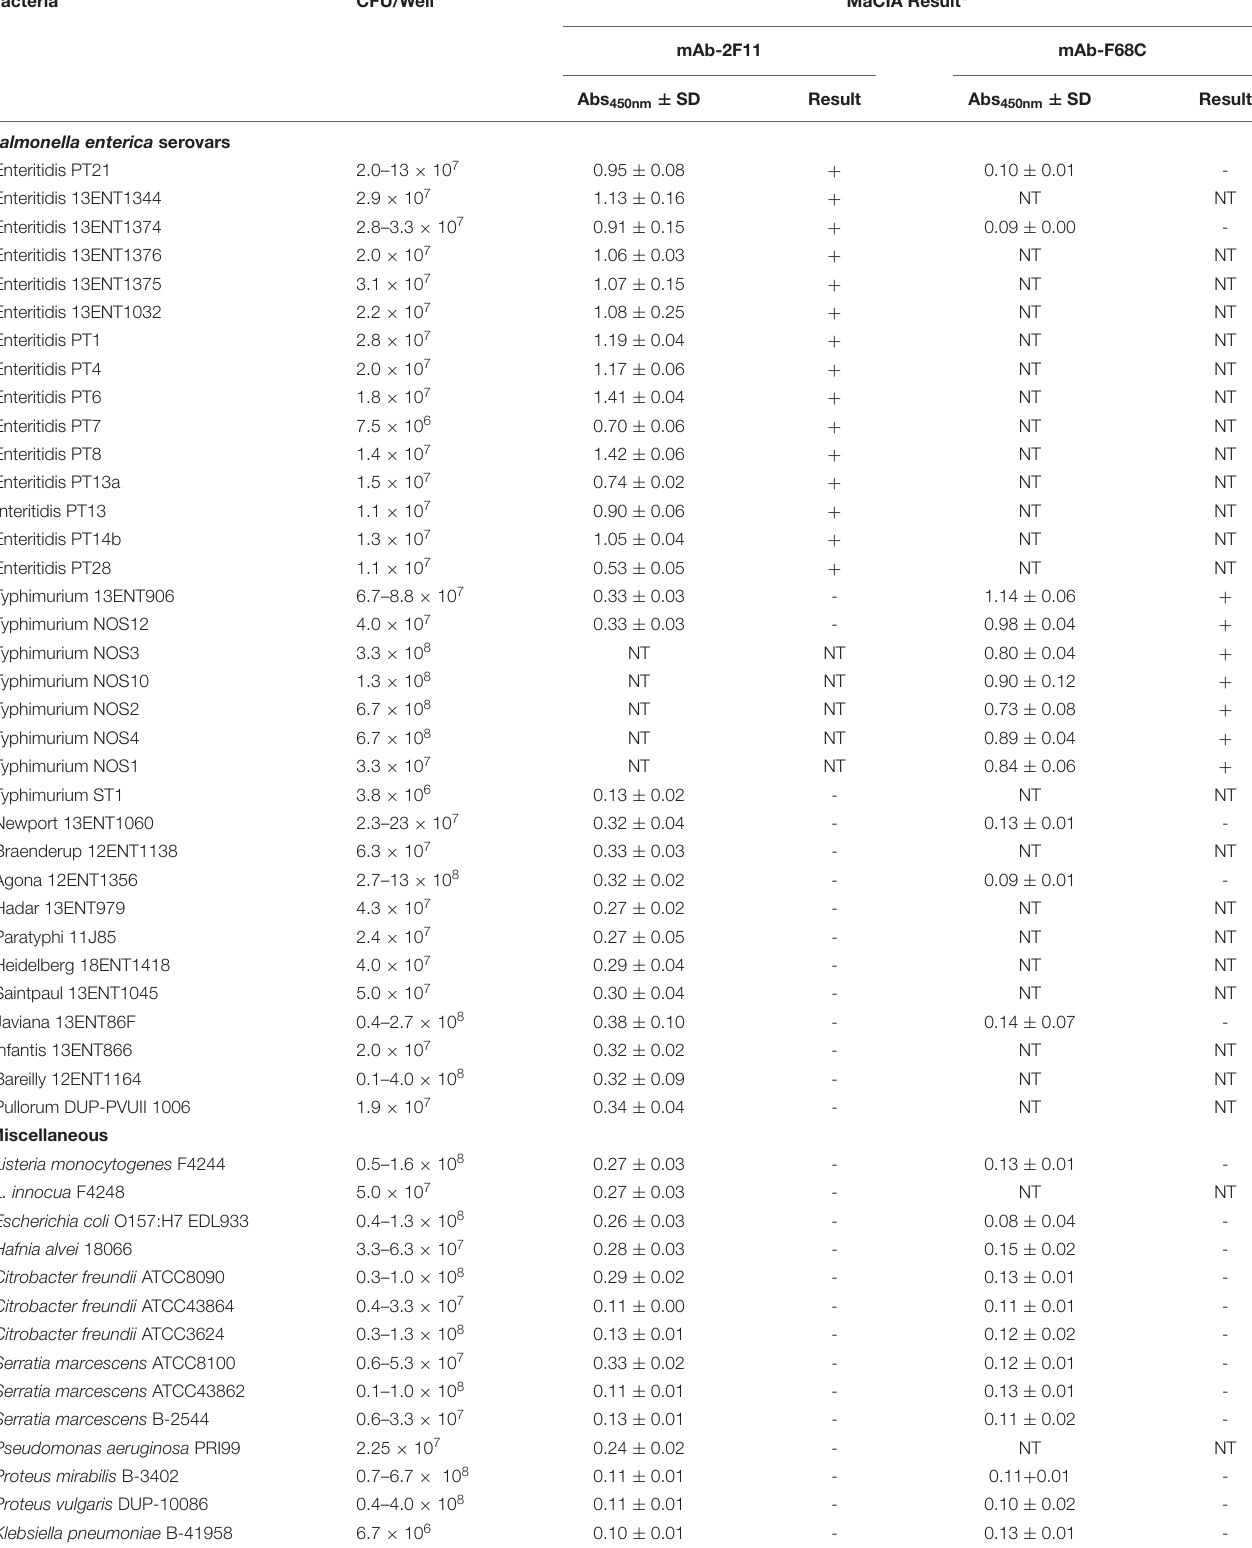
TABLE 1 | Specificity of mammalian cell-based immunoassay (MaCIA) platform tested against Salmonella and non- Salmonella spp. Bacteria